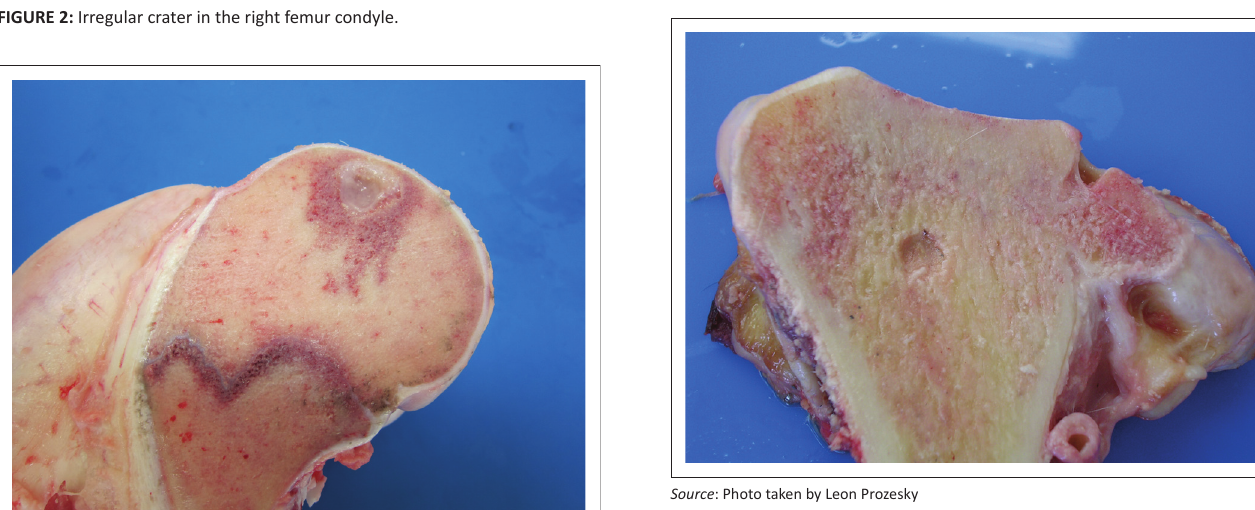
FIGURE 6: Cyst at the level of the growth plate (older